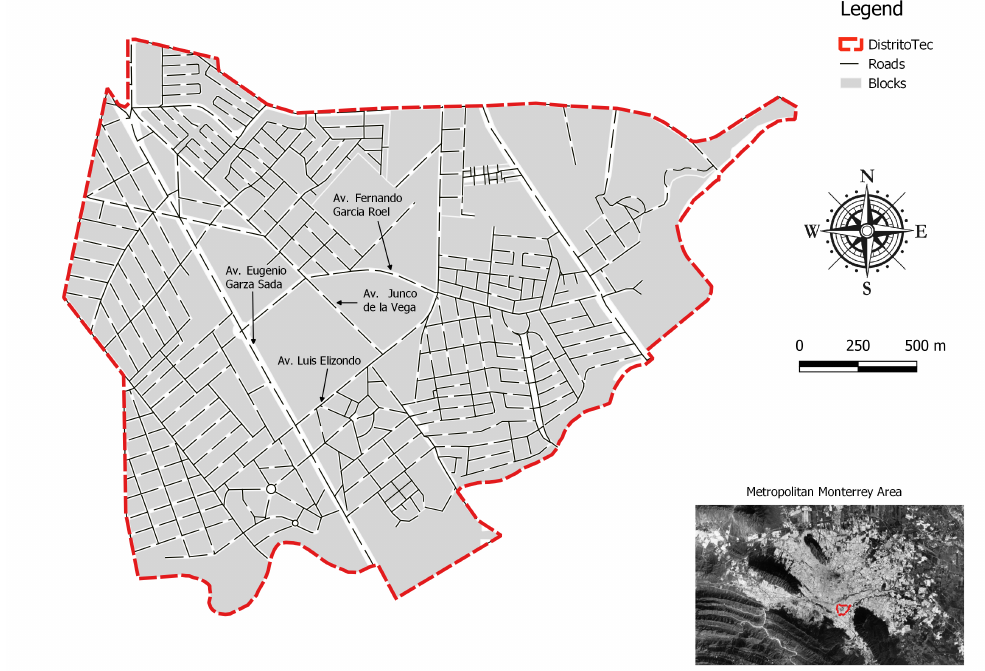
Figure 5. Localization of DistritoTec in the Metropolitan Monterrey